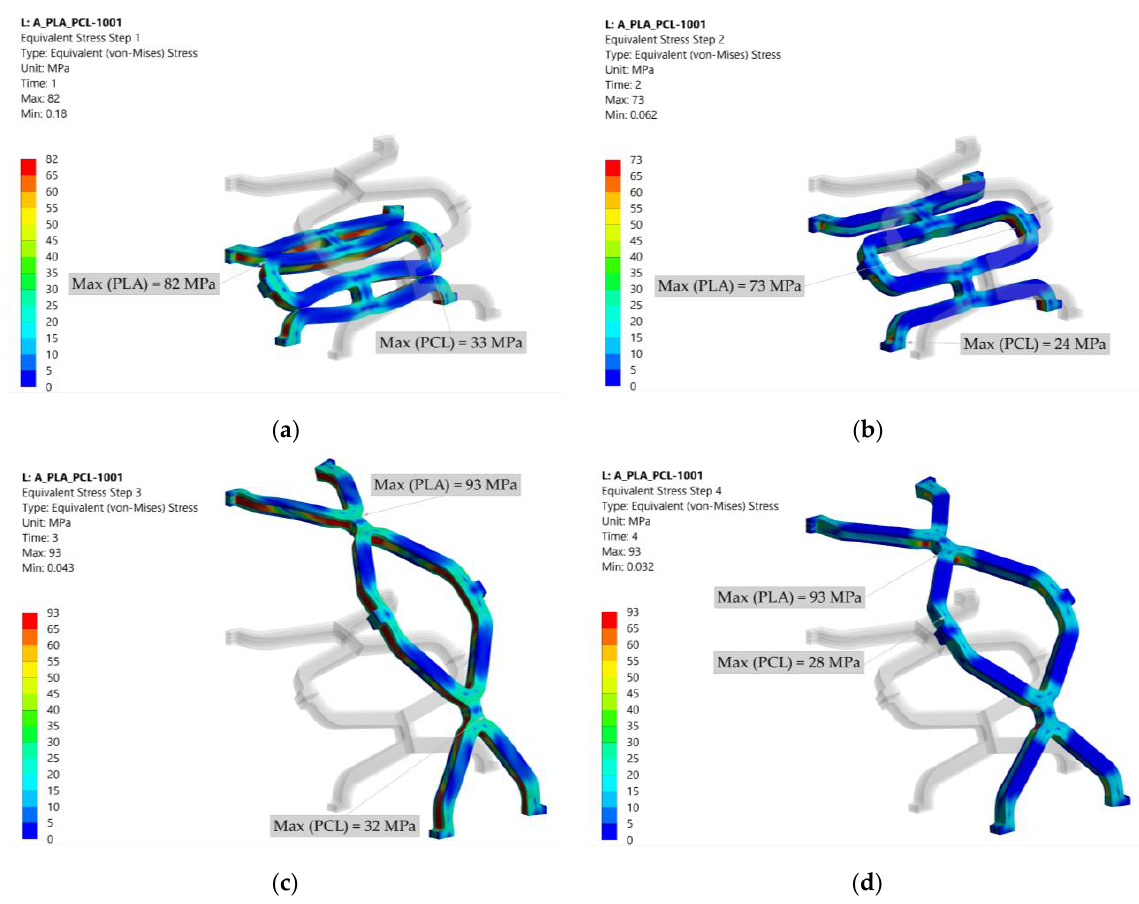
Figure 6 . Equivalent (von Mises) stress results in MPa for configuration 1001 (deformation scale factor: 1): ( a ) stress after crimping; ( b ) residual stress after crimper removal; ( c ) stress after expansion; ( d ) residual stress after balloon removal.